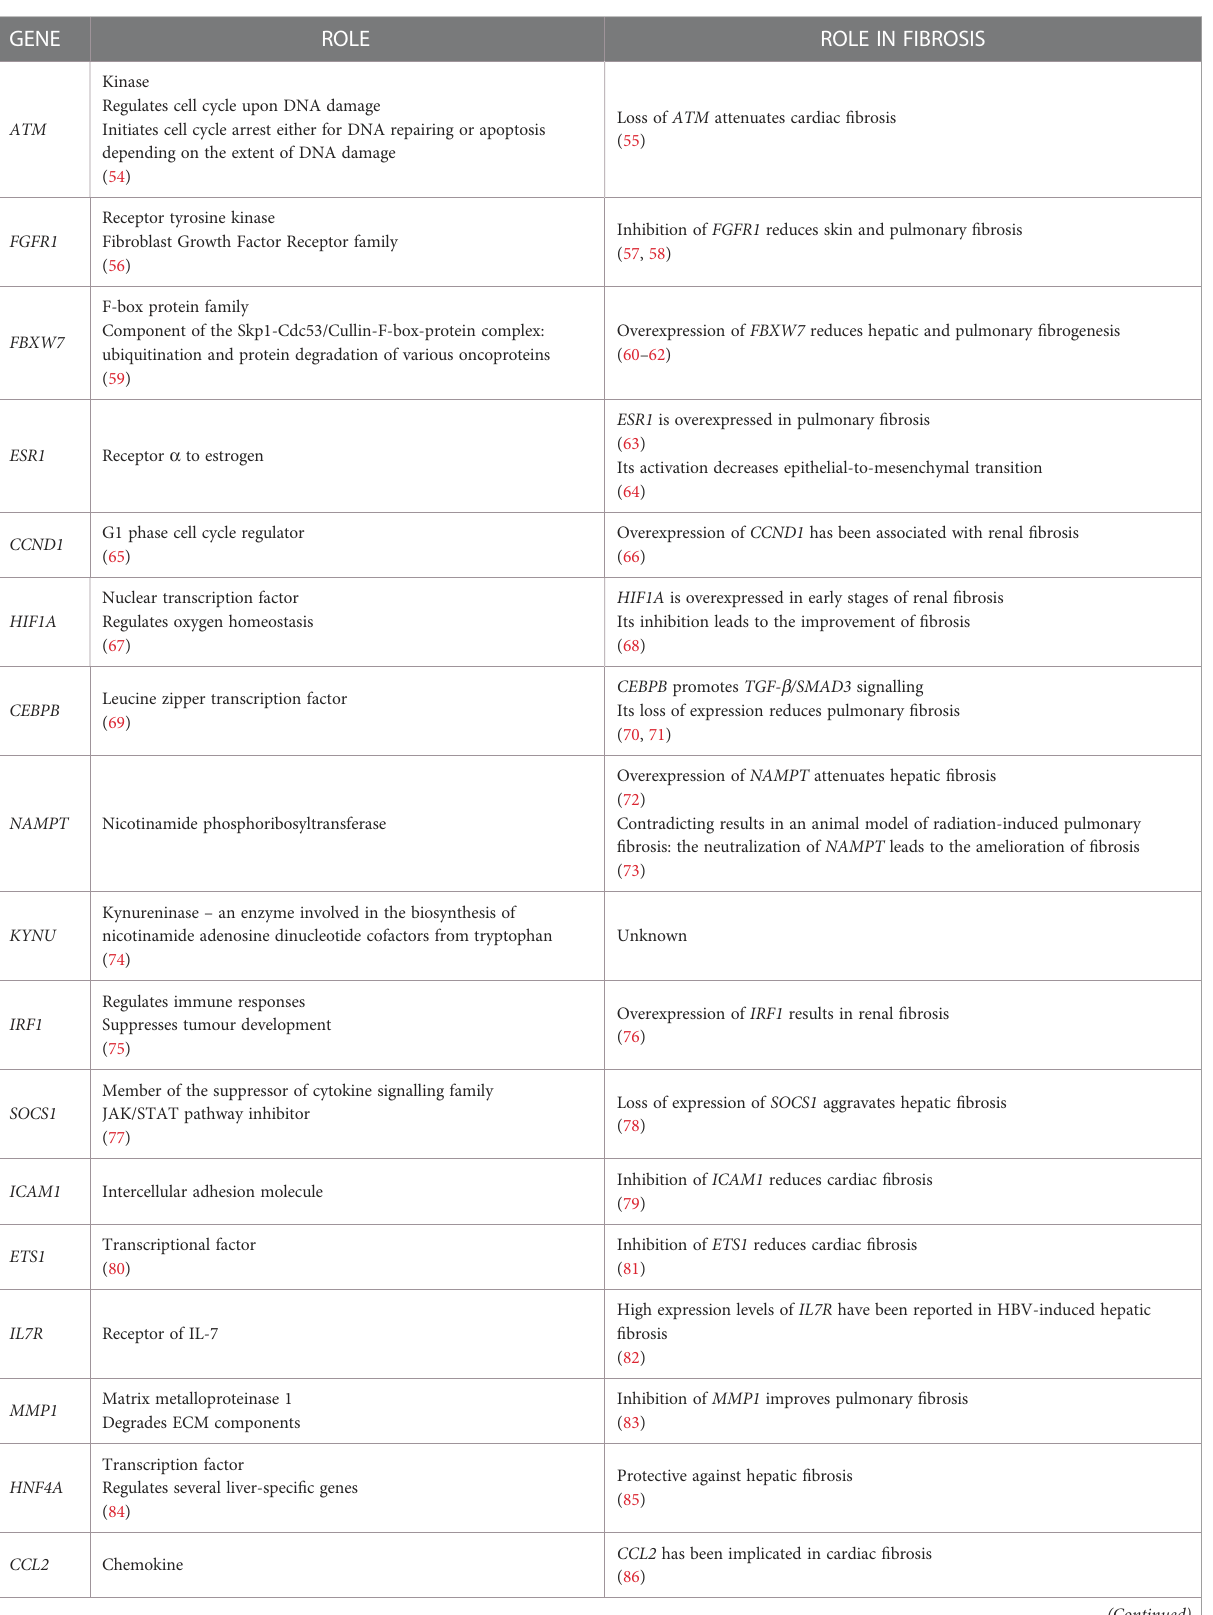
TABLE 4 The role of the 21 hub genes in fi brogenesis.